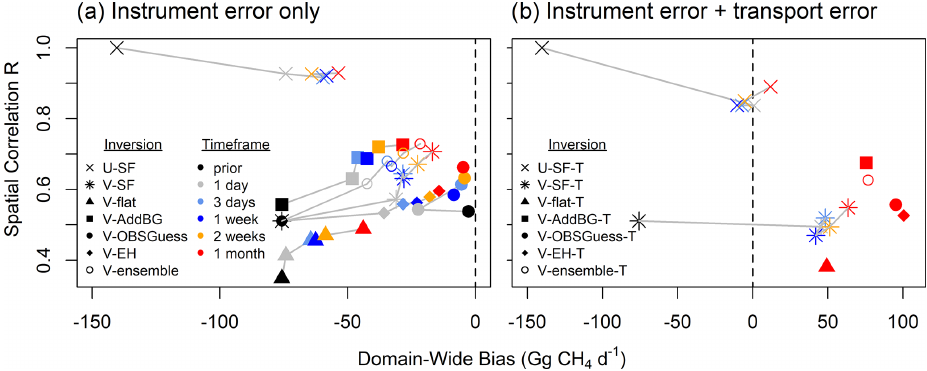
Figure 8. OSSE performance for timescales ranging from 1d to 1 month (colors) as a function of inversion framework (symbols). Table 1 provides the inversion details for each case. Panel (a) shows results for synthetic observations subject to instrument error only, while panel (b) shows results that also include model transport errors (panel b shows only the 1 month results for the alternative